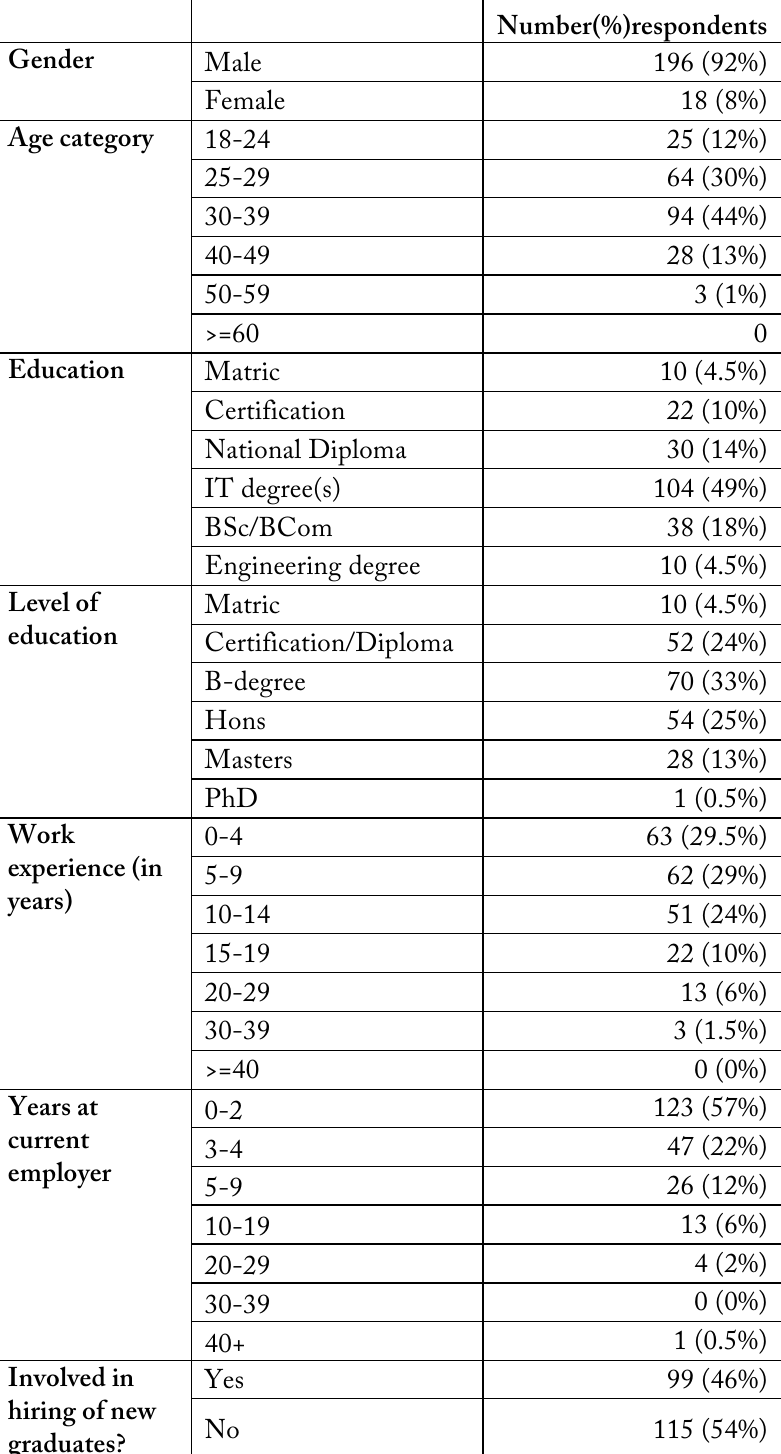
Table 1: Profile of respondents